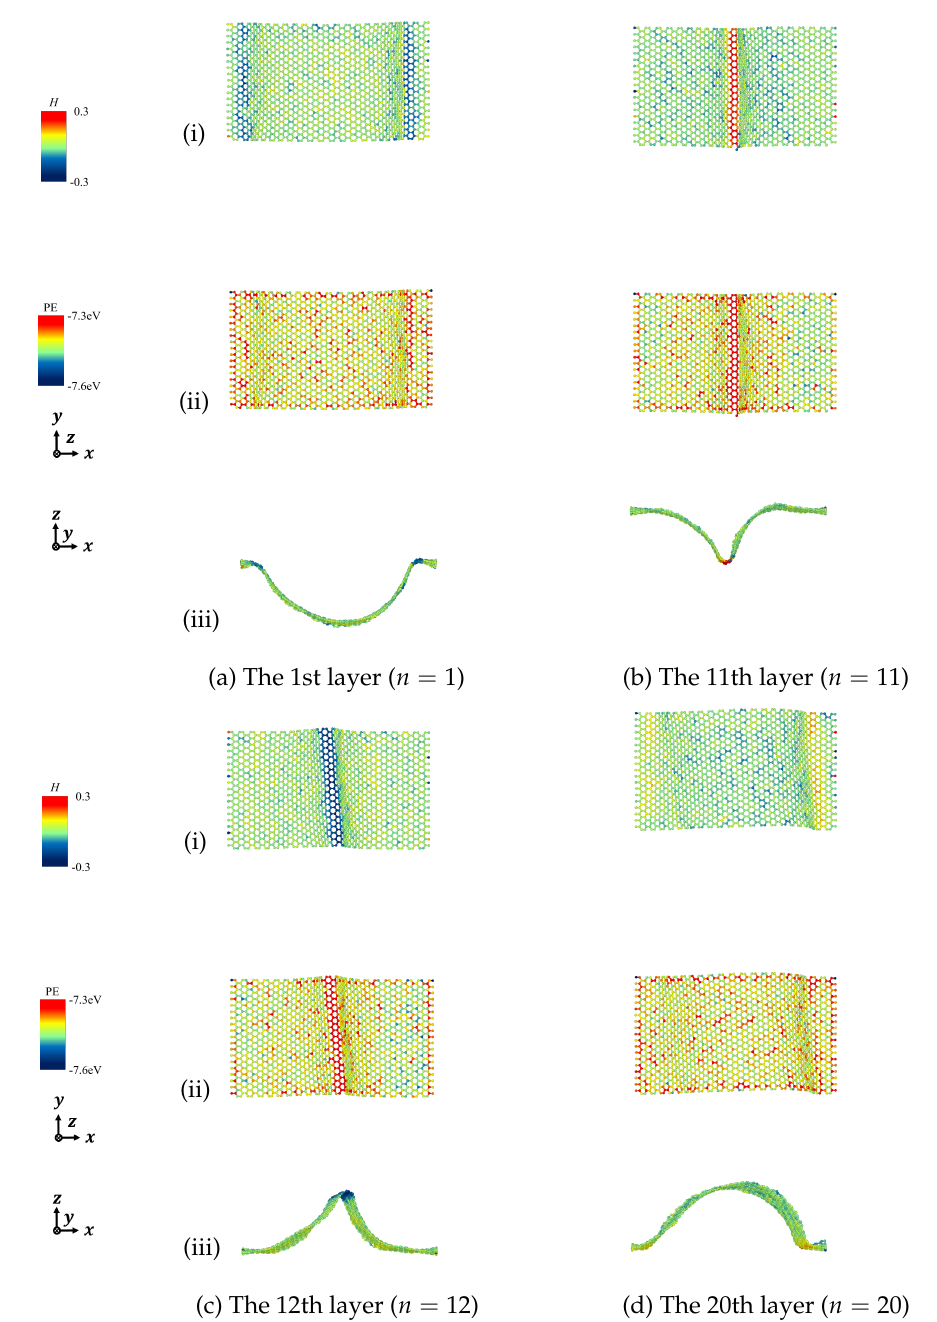
Figure 12. Mean curvature and site potential energy of curved surface of armchair graphite under compression ε = 0.20. (i) Site mean curvature, (ii) Site potential energy, and (iii) Mean curvature with deformation.